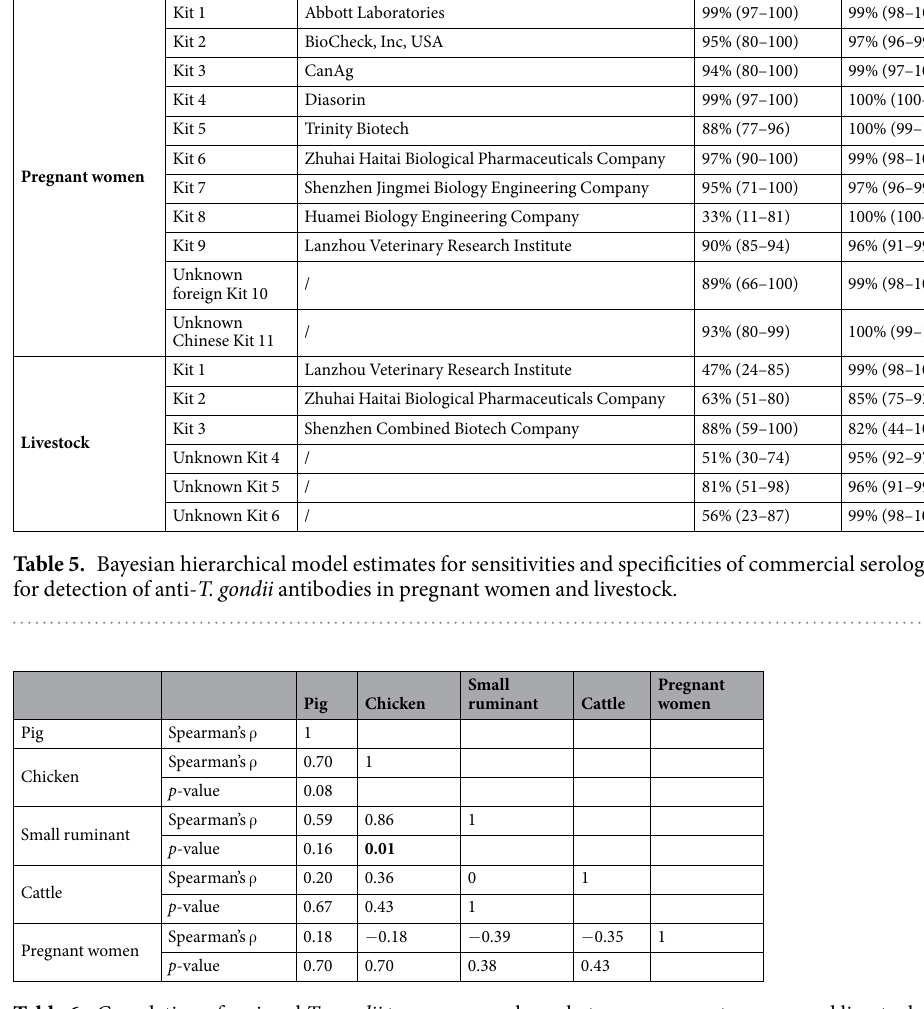
Table 6. Correlation of regional T. gondii true seroprevalence between pregnant women and livestock in mainland of